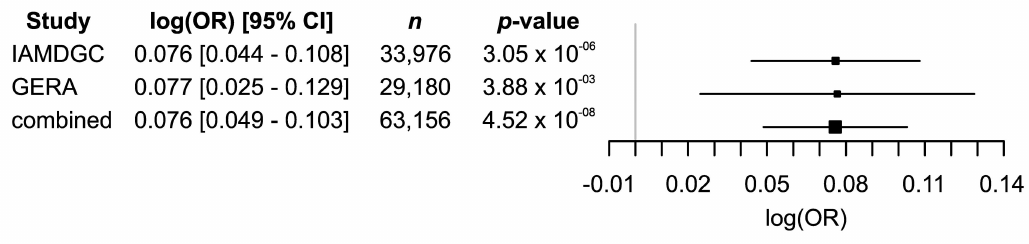
Figure 1. Genome-wide association of age-related macular degeneration (AMD) with rs2168518. The association was calculated separately in the International AMD Genomics Consortium (IAMDGC) and Genetic Epidemiology Research on Adult Health and Aging (GERA) datasets, as well as in the combined data where the association of AMD with rs2168518 displays genome-wide significance ( p -value < 5 × 10 − 8 ). For all associations, the A allele indicates the e ff ect allele. OR = odds ratio, CI = confidence intervals, n = sample